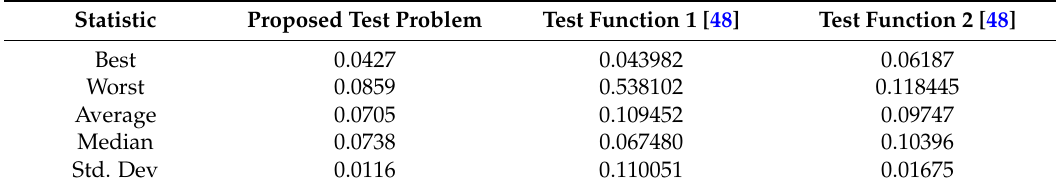
Table 8. The spacing results of MOPSO with proposed test problem and other test problem solved in [48].